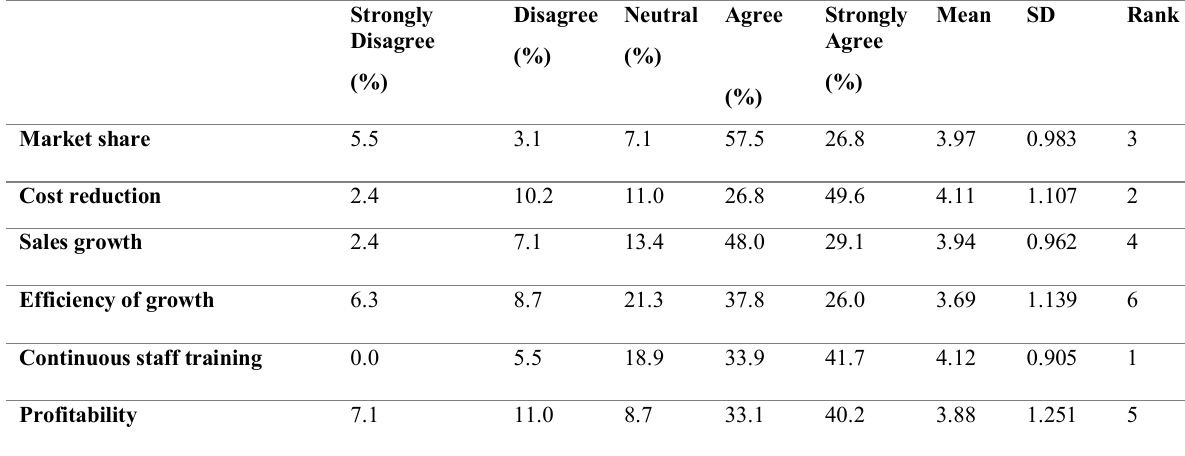
Table 2: Descriptive statistics for firm’s performance in Kenya